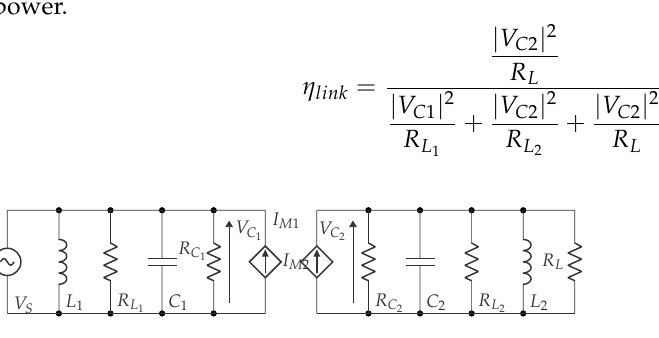
Figure 13. Equivalent scheme with VCCS